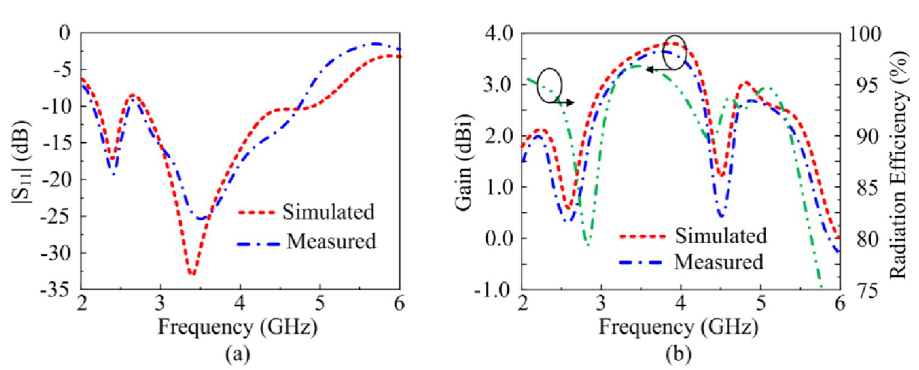
Fig 10. The reflection-coefficient, gain and radiation efficiency response of the proposed antenna when both PIN diodes are forward biased.